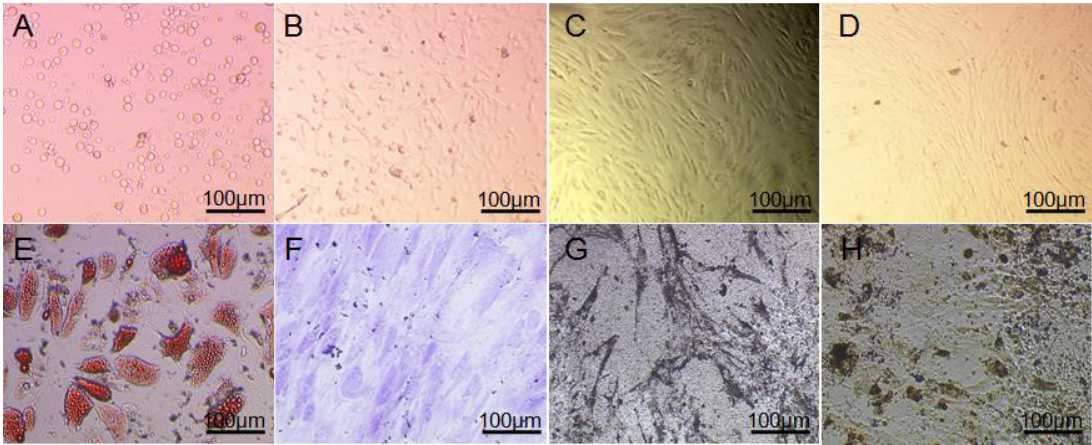
Figure 1. Primary and sub-cultured human adipose tissue-derived stem cells (ADSCs) and their multi-differentiation assays. ( A ) 12 h; ( B ) 3 days; ( C ) 7 days; ( D ) 3 days (P3); ( E ) Stained by oil red O after 2 weeks of differentiating towards adipocytes; ( F ) Stained by toluidine blue after 2 weeks of differentiation towards chondrocytes; ( G ) Alkaline phosphatase (ALP) staining after 2 weeks of differentiation towards osteoblast; ( H ) Von-kossa staining after 4 weeks of differentiation towards osteoblast. Scale bar: A – H , 100